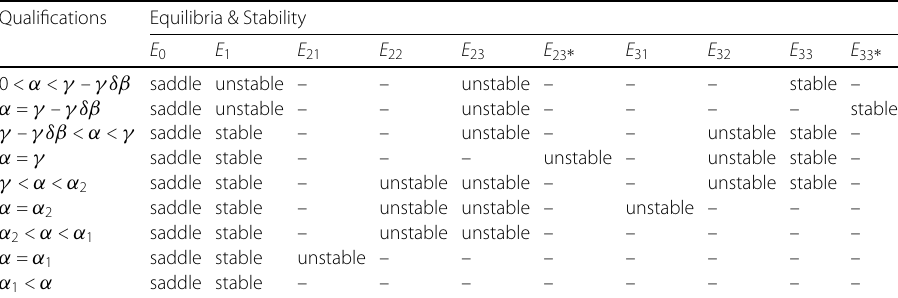
Table 1 The existence and stability of equilibria of system (1.3), where γ < 1 –